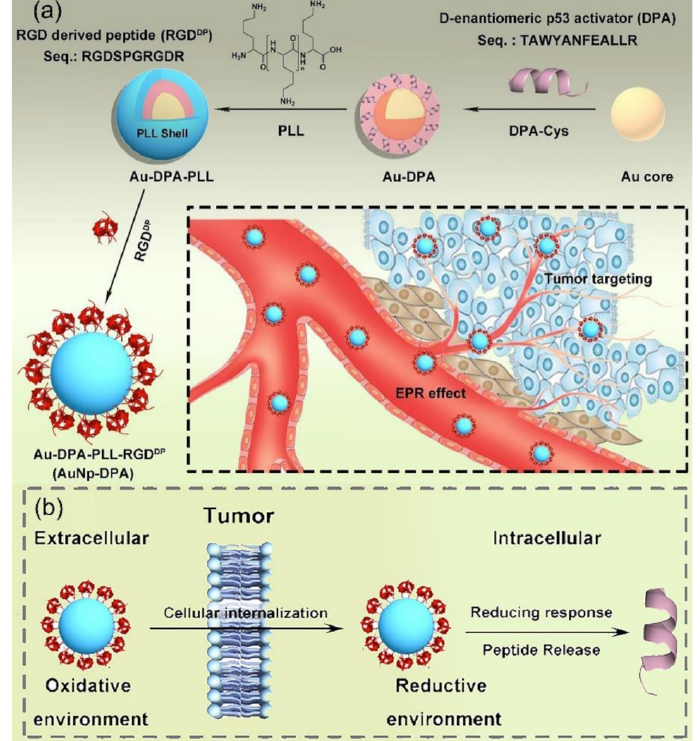
Figure 11. ( a ) Schematic depiction for the synthesis of AuNP-DPA and their enrichment in the tumor site. The AuNPs were modified by the C terminus of DPA (DPA-Cys, encapsulated by PLL, and functionalized by RGD-derived peptide RGDDP. ( b ) The AuNP-DPA can efficiently re-lease DPA to the cytosol through breaking the gold-thiolate bonds by the intracellular reductant, such as GSH. (Adapted from Bian et al. 2018 [257], Copyright 2018 Ivyspring International Pub-lisher and reproduced with